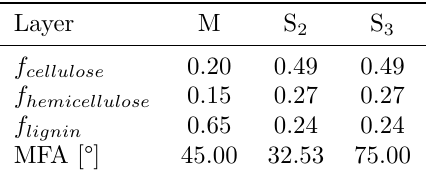
Table 2. Volume fraction of cell wall constituents and MFA of individual cell wall layers [2].